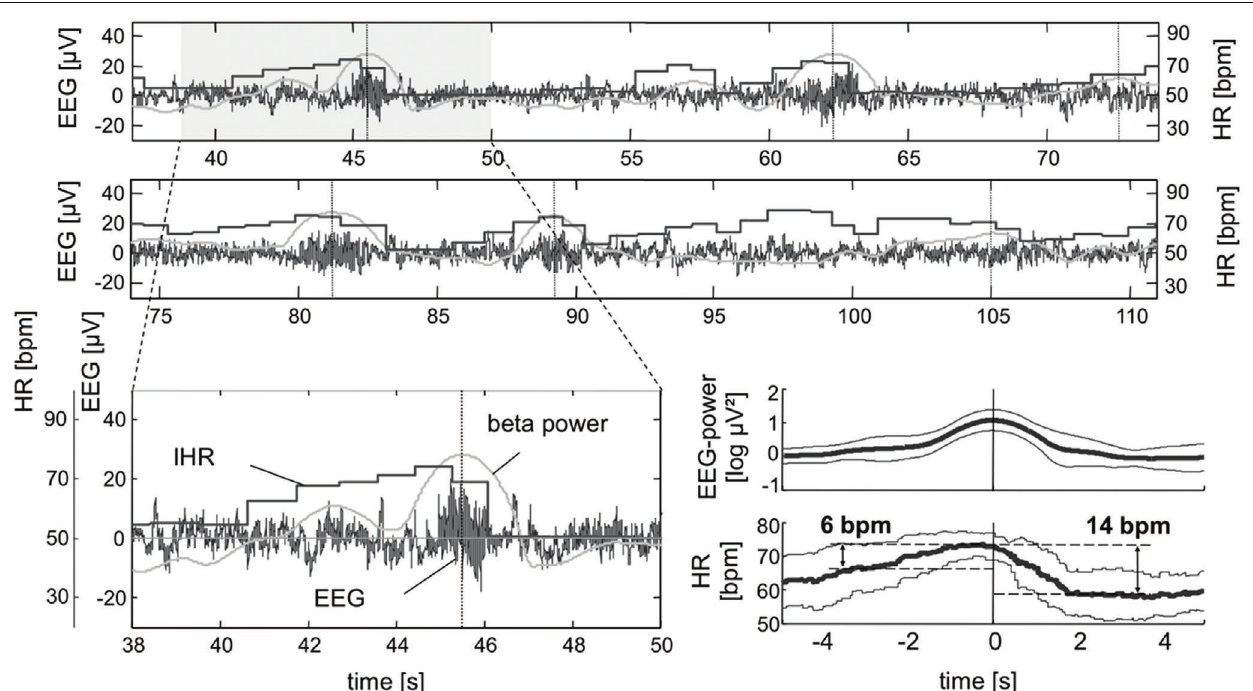
FIGURE 5 | Raw EEG, heart rate and time course of the logarithmic band power (15–19 Hz), enlarged from a 10-s time window (lower panel, left), and averaged logarithmic beta power (mean ± SD) together with